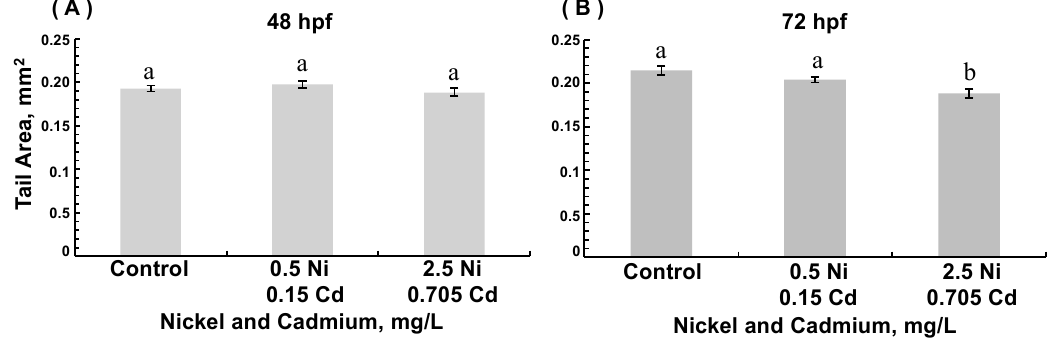
Figure 5. Tail area in 48 hpf ( A ) and 72 hpf ( B ) zebrafish embryos reared in medium containing combinations of 0.5 mg/L Ni + 0.15 mg/L Cd or 2.5 mg/L Ni + 0.705 mg/L Cd. ( B ): 72 hpf with combined metal exposure, ANOVA p = 0.0030. (Data are means ± SEM for N = 50–80 surviving embryos.).